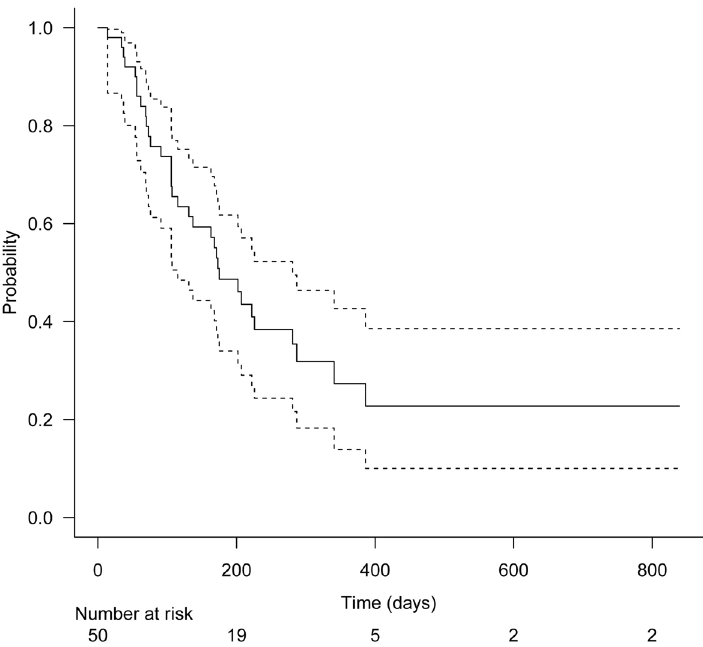
Figure 4. Kaplan–Meier analysis of overall survival. The median overall survival was 175 (95% confidence interval, 115–281)